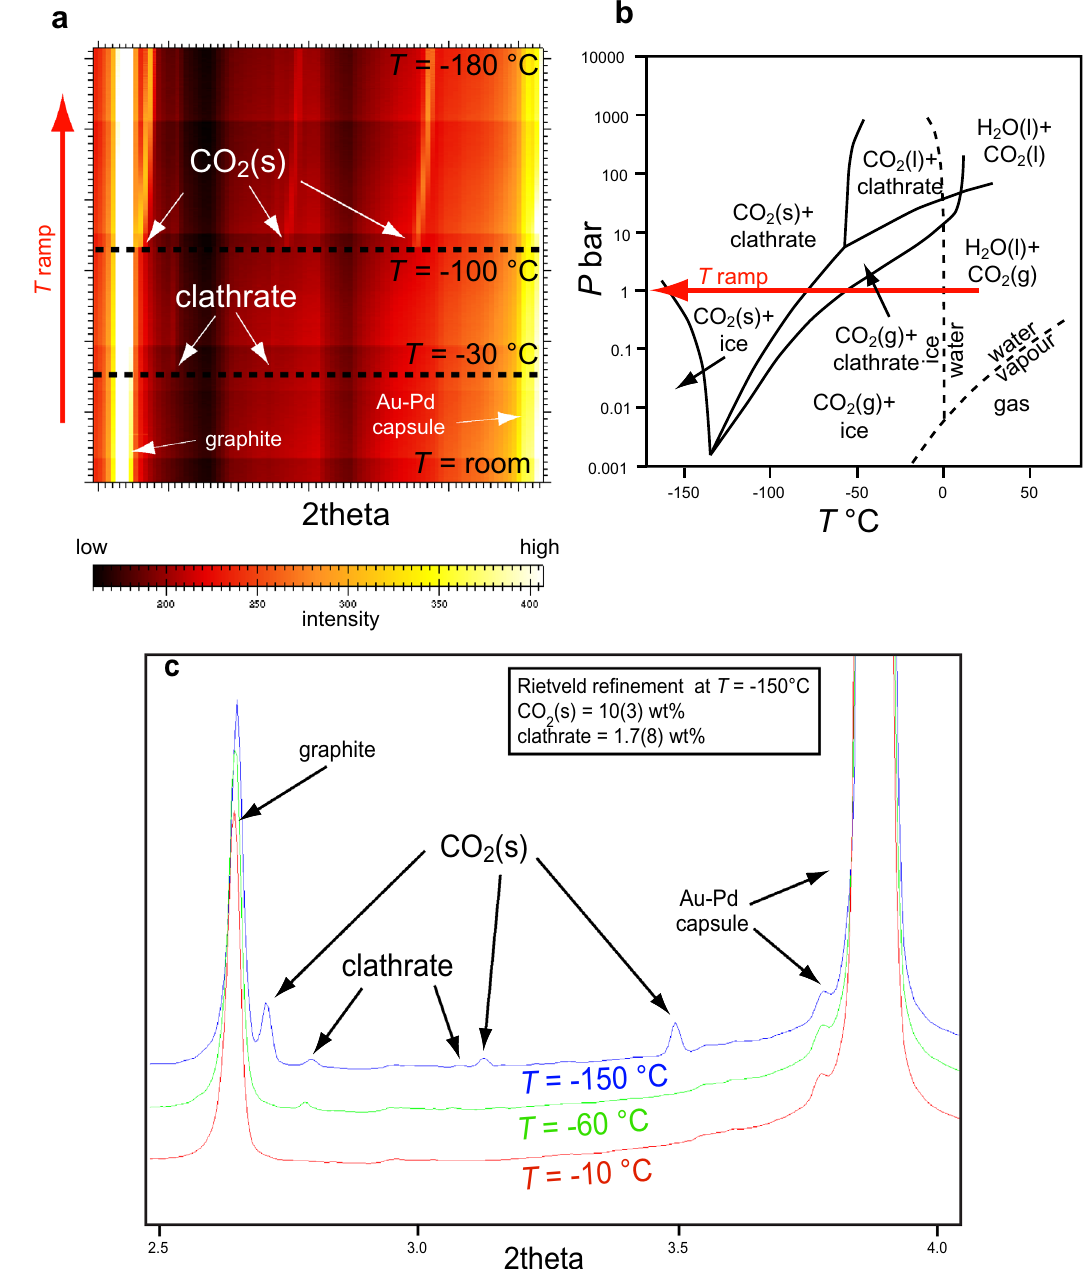
Figure 2. X-ray diffraction data collected during the cooling ramp from room temperature down to − 180 °C. ( a ) Clathrate and solid CO 2 diffraction effects are detected below − 30 °C and − 100 °C, respectively. ( b ) Low- temperature phase diagram for the H 2 O–CO 2 system redrawn after 10 ; the experimental cooling ramp is shown by a red arrow. ( c ) Representative X-ray diffraction patterns collected at − 10 °C, − 60 °C and − 150 °C; the Rietveld refinement of the − 150 °C pattern yields 10 ± 3 wt% CO 2(solid) and 1.7 ± 0.8 wt% clathrate (a 100 wt% closure is imposed on the sum of CO 2(solid) + clathrate +